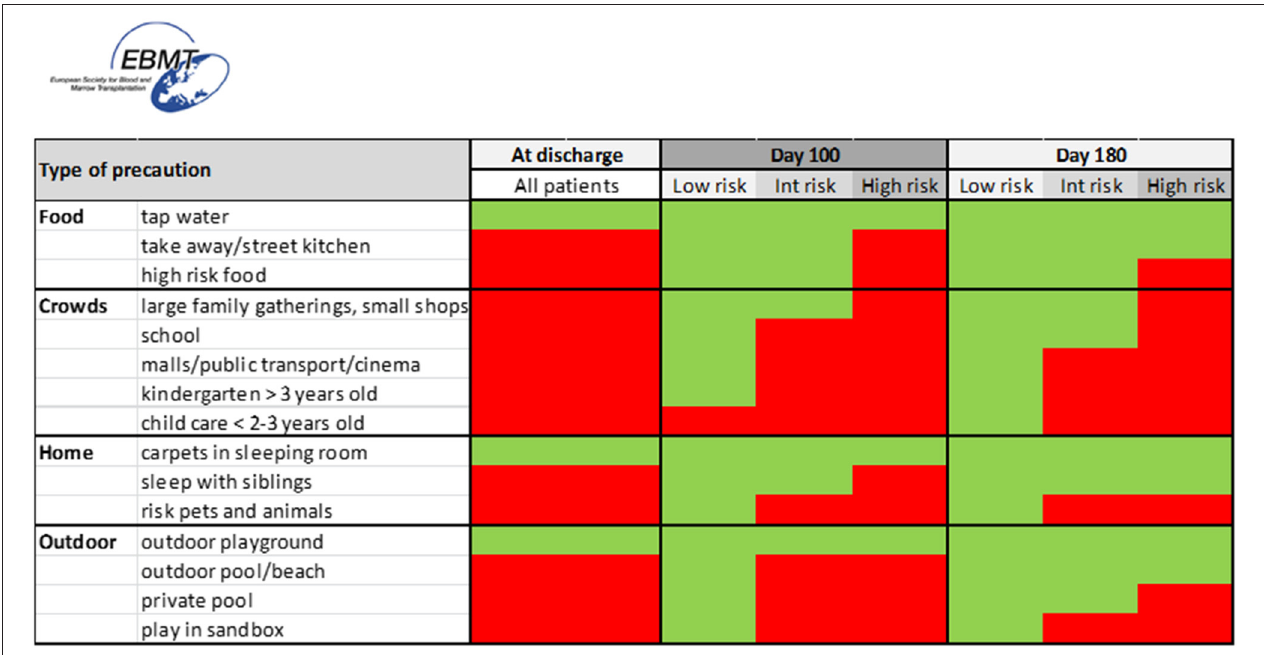
prophylaxis/treatment of GvHD that impacts immune